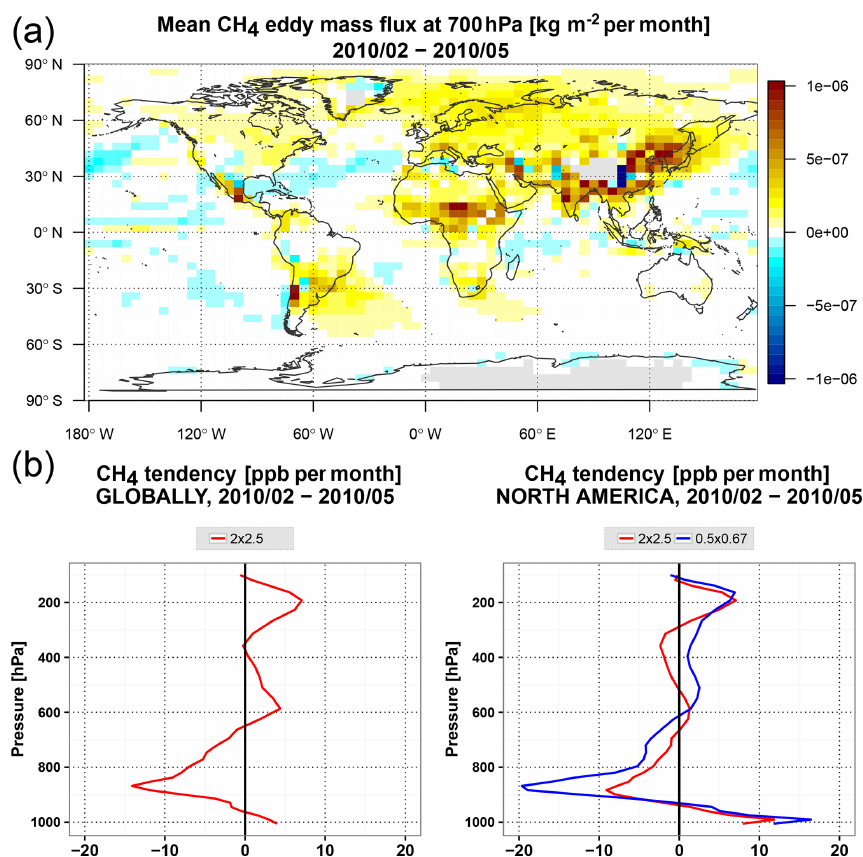
Figure 13. (a) The mean CH 4 eddy mass flux at 700hPa for February–May 2010 lost by degrading the model resolution from 2 ◦ × 2 . 5 ◦ to 4 ◦ × 5 ◦ . (b) The vertical profile of the globally averaged CH 4 tendency (ppb per month) caused by the CH 4 eddy mass flux lost by degrading the model from 2 ◦ × 2 . 5 ◦ to 4 ◦ × 5 ◦ . Right panel: the vertical profile of the CH 4 tendency over North America caused by the eddy mass flux lost by degrading the model resolution from 2 ◦ × 2 . 5 ◦ to 4 ◦ × 5 ◦ (red) and from 0 . 5 ◦ × 0 . 67 ◦ to 4 ◦ × 5 ◦